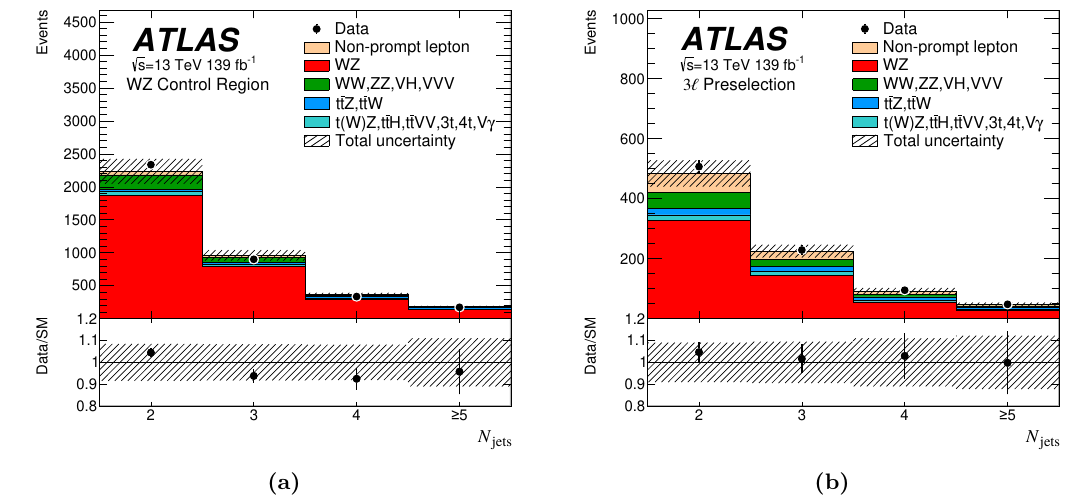
Figure 2 . Distribution of the jet multiplicity in the (a) WZ control region and in the (b) 3 ‘ preselection region. The data (dots) are compared with the estimated contributions from the background sources (histograms). The normalisation factor is applied to the WZ MC contribution. The last bin includes overflows. In each figure the bottom panel shows the ratio of data to the estimated background. The hatched band around unity represents the total uncertainty of the